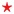
Stability test: Square wave potential steps at frequency 0.1 Hz (1000 cycles) in potential range 1 V to -0.55 V in LiTFSI-PC showing in a: the strain ε of CFS-PPy/DBS (black) and CFS-PPy/TF (red) against time t and in b: the strain ε (main values with standard deviation) of CFS-PPy/DBS (■) and CFS-PPy/TF (★) against cycle number.